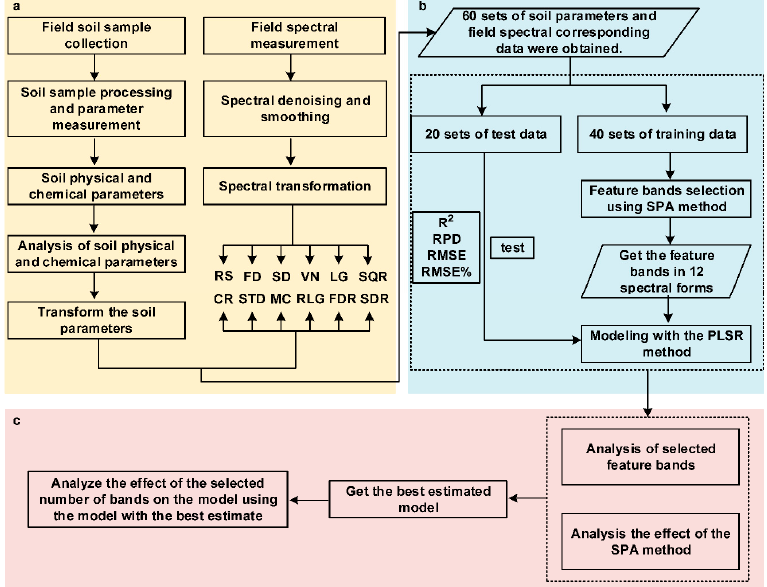
Figure 3. Method flow chart. ( a ) Data preprocessing; ( b ) modeling; and ( c ) analysis.